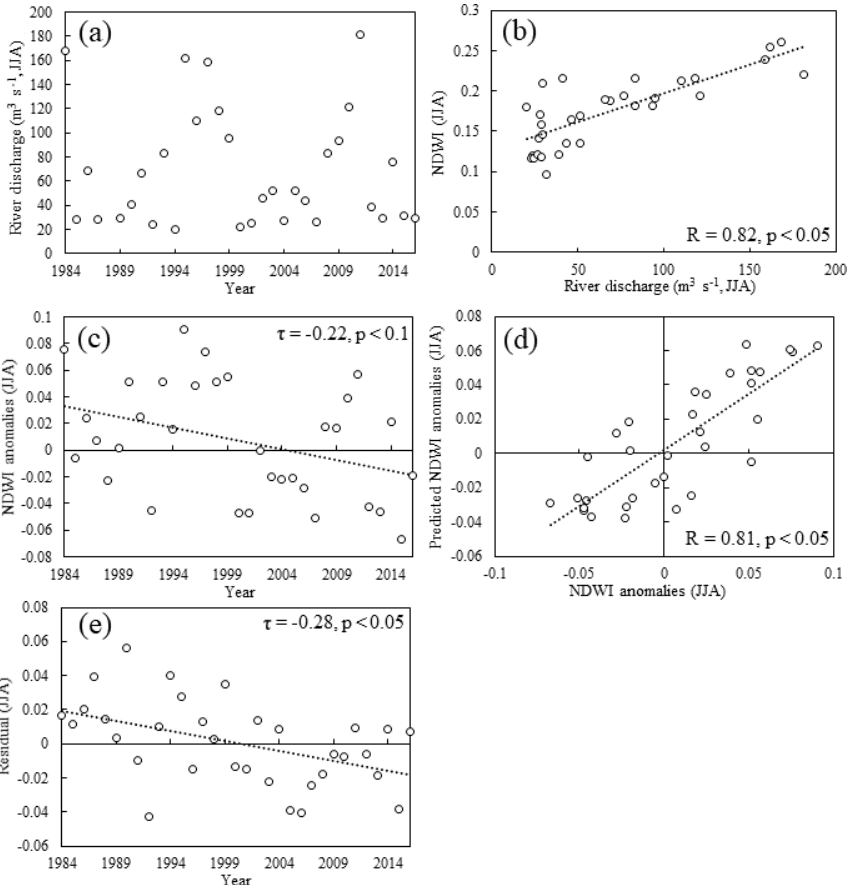
Figure 5. Statistics for the Jefferson River riparian reach at the basin outlet (JR1), including (a) variability in June, July and August (JJA) river discharge over time (station ID: 6036650); (b) relationship between the normalized difference wetness Index (NDWI) and river discharge; (c) trend in NDWI anomalies over time; (d) correlation between NDWI anomalies and predicted NDWI anomalies; and (e) trend in NDWI anomaly–climate regression residuals over